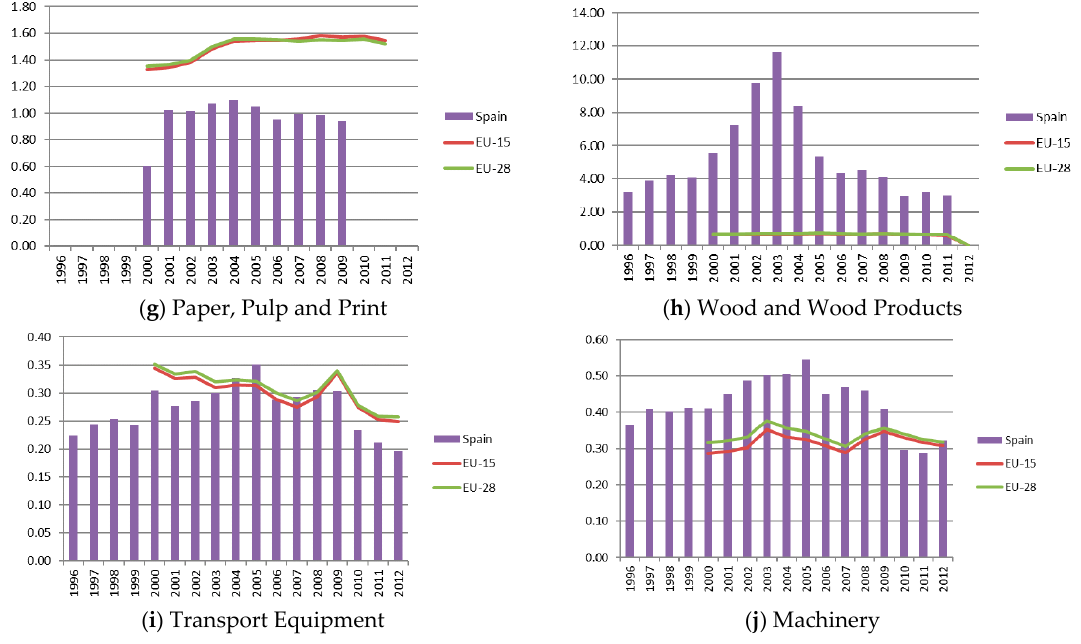
Figure 10. Industrial activities intensity. Measured in GWh/million € GVA (2005). Source: Own calculations with Eurostat data.